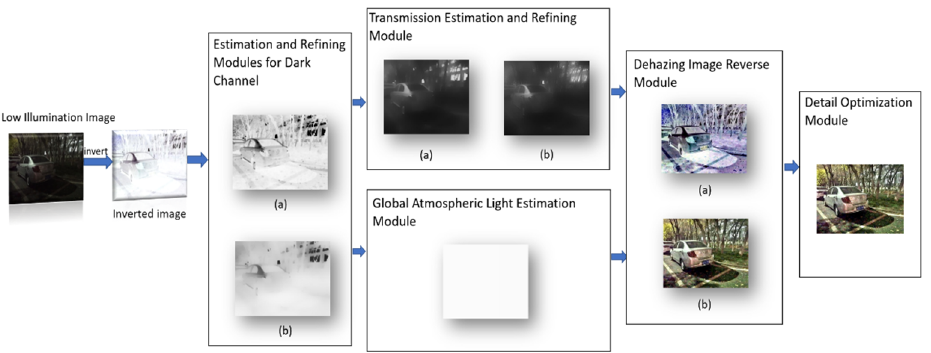
Figure 1. Flowchart of the proposed method. Among it, in the dark channel estimation and refinement module ( a ) is the dark channel estimation result, ( b ) is the dark channel refinement result; in the transmission estimation and refinement module ( a ) is the transmission estimation result, ( b ) is the transmission refinement result; in the dehazing image reverse module ( a ) is the dehazing image, and ( b ) is the initial enhanced image obtained by reverse.